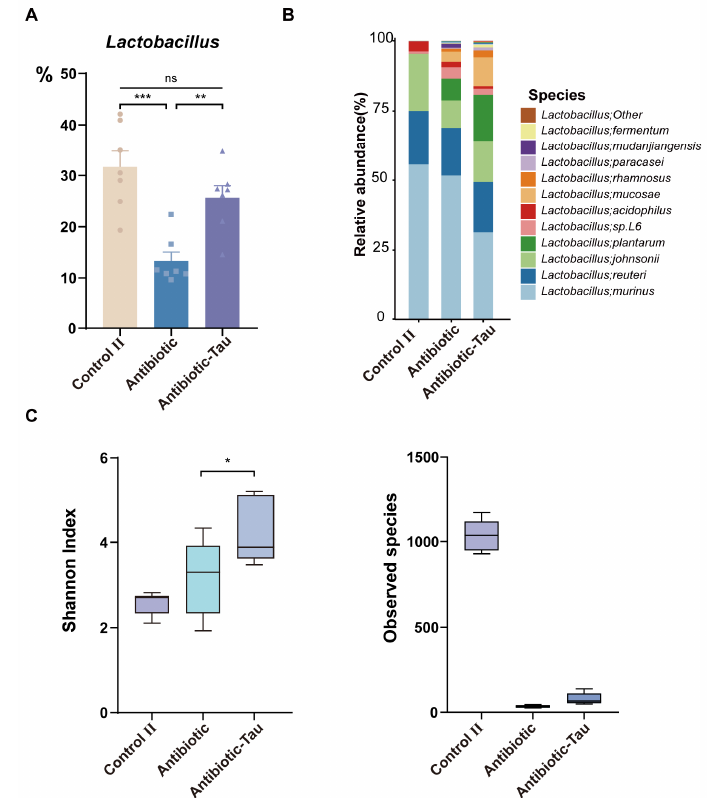
Figure 5. Effect of taurine supplementation on Lactobacillus during antibiotic treatment and recov- ery periods. ( A ) Relative abundance of Lactobacillus after 7 days of antibiotic exposure (Day 14). ( B ) Relative abundance of Lactobacillus at the species level. ( C ) Lactobacillus α -diversity during antibiotic treatment. Data are presented as the means ± SEM * p < 0.05, ** p < 0.01, *** p < 0.001, and p > 0.05 = not significant (ns, may not be indicated), by one-way ANOVA followed by Tukey’s test.